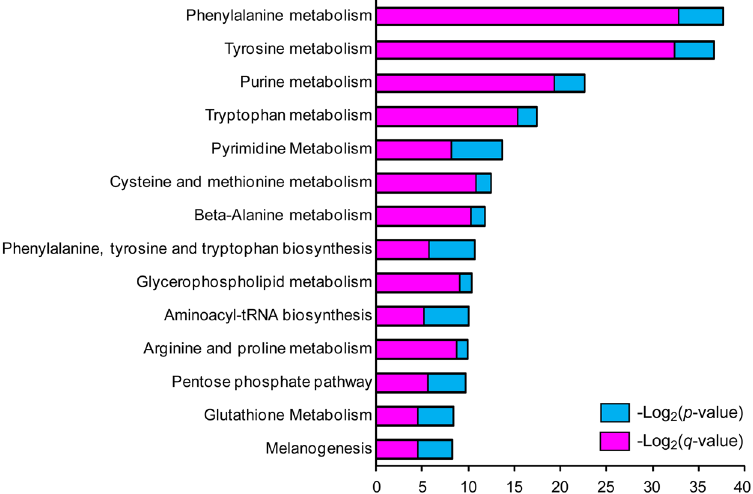
Figure 5. Dysregulated Metabolic pathways in human CSF of preclinical AD vs. control patients. P -values and corrected p -values of metabolic pathways were calculated by weighing the number of compounds in the set against in the background in MBROLE